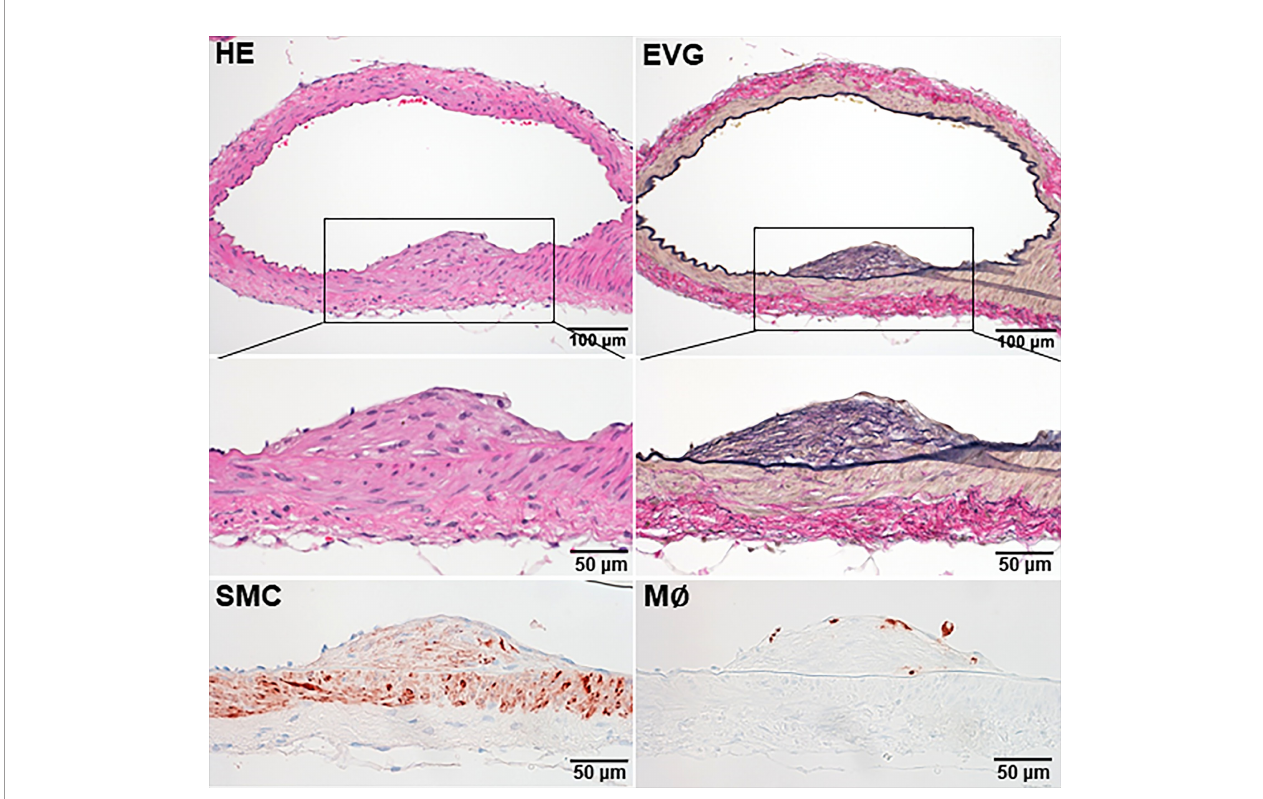
FIGURE 3 | Histological features of intracranial atherosclerosis of a cholesterol diet-fed apoE KO rabbit. Paraf fi n-embedded specimens were stained with Hematoxylin-eosin (HE) and elastica van Gieson (EVG) or immunohistochemically stained with antibodies against either macrophages (M ∅ ) or smooth muscle cells (SMC). A small intimal lesion sized 250 m m in length was observed in PCA and mainly composed of fi brous tissue with a few smooth muscle cells and macrophages. This kind of lesions was only observed in 3 rabbits among 12 apoE KO